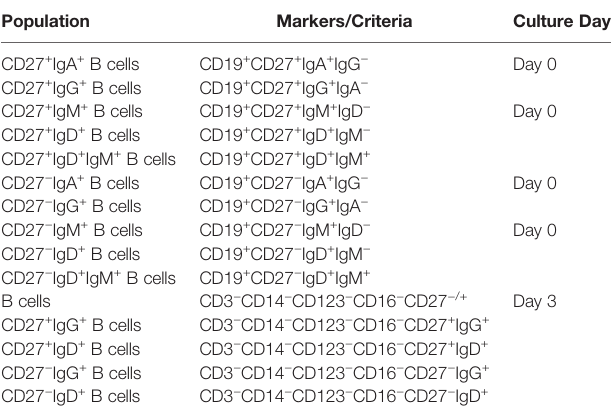
TABLE 5 | Flow cytometry patterns used to characterize PSGL-1 expression on different CD27 + and CD27 − B cells subpopulations.